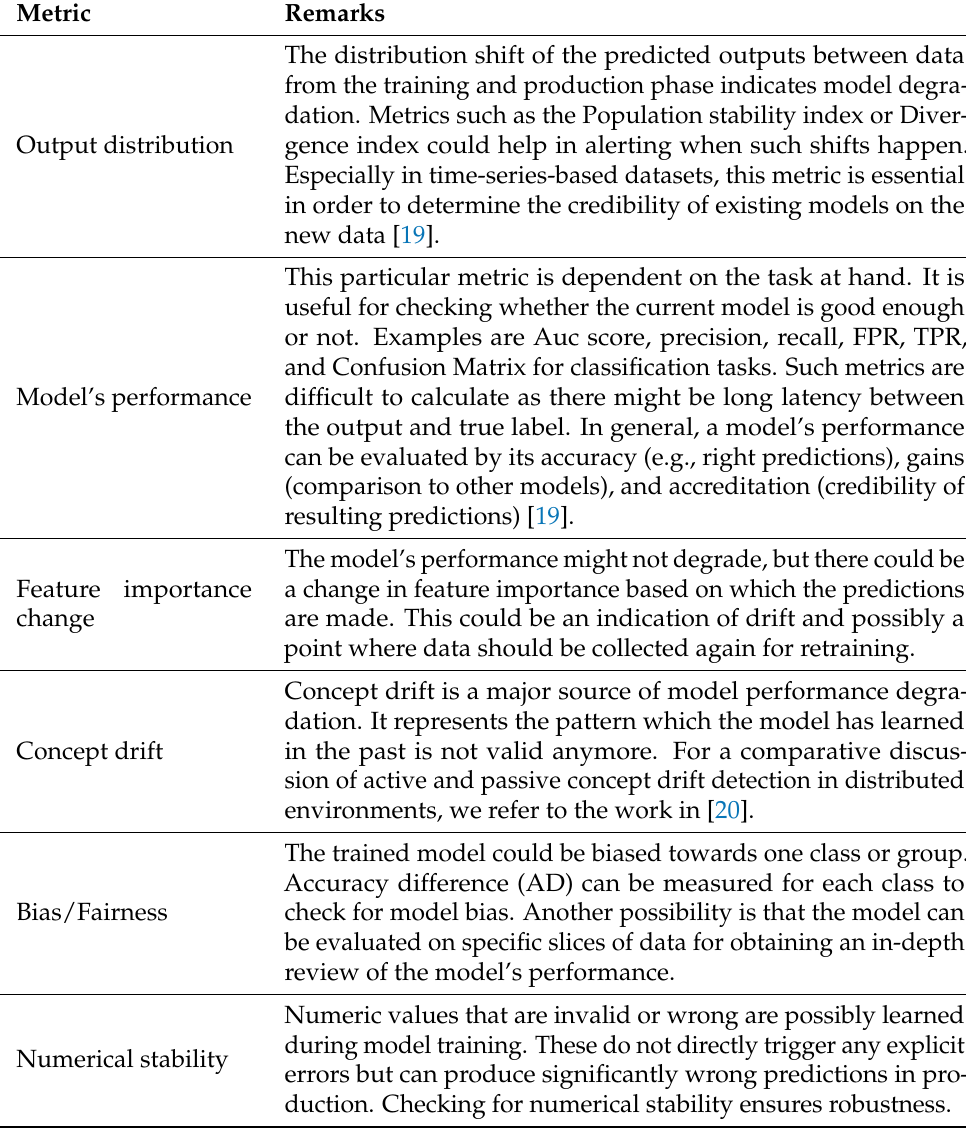
Table 4. The different metrics that can be used for monitoring ML